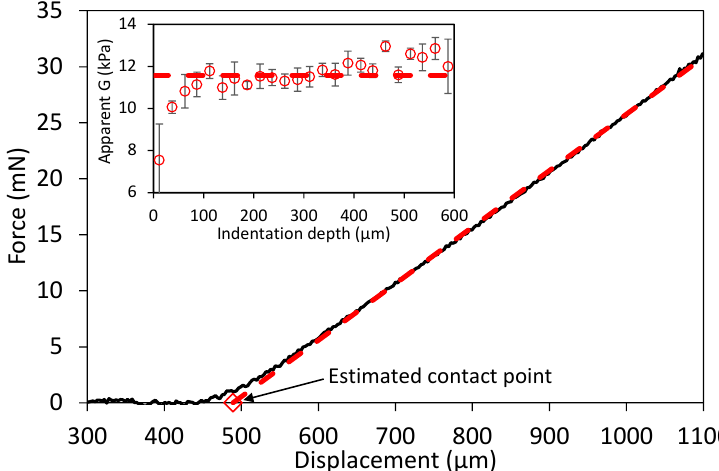
Figure 2. An example of an indentation of a whey protein isolate (WPI) hydrogel swollen from 3 min in water. The contact point is estimated by robust regression at large force values (dashed line), e.g., 6–31 mN here. The apparent shear modulus is then calculated using Equation (1) at different indentation depths at 25 μ m intervals, shown in the inset, only for the purpose of checking the mechanical homogeneity of the indented layer. Error bars show the 95% CI of the fitted G. The dashed line in the inset is the average G between 50–500 μ m.